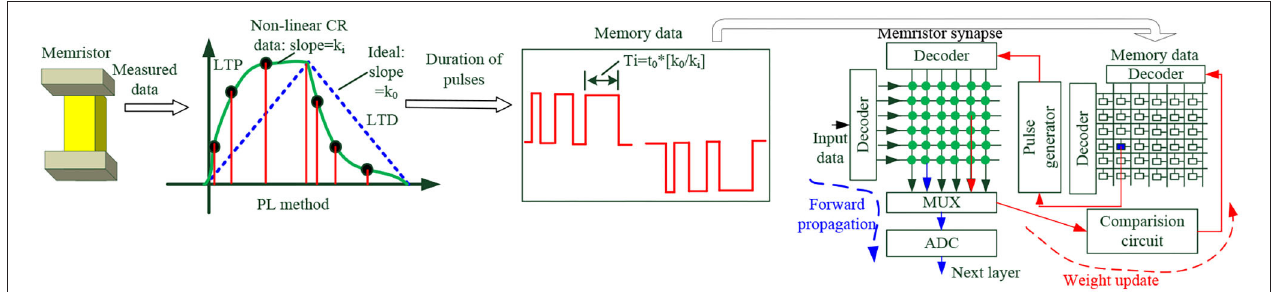
FIGURE 5 | Co-design from memristor non-ideal characteristics to the ANN algorithm (Fu et al., 2019).